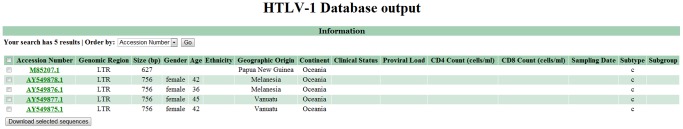
The HTLV-1 Molecular Epidemiology Database query results table.Retrieved information is posted as a table and the results may then be downloaded.